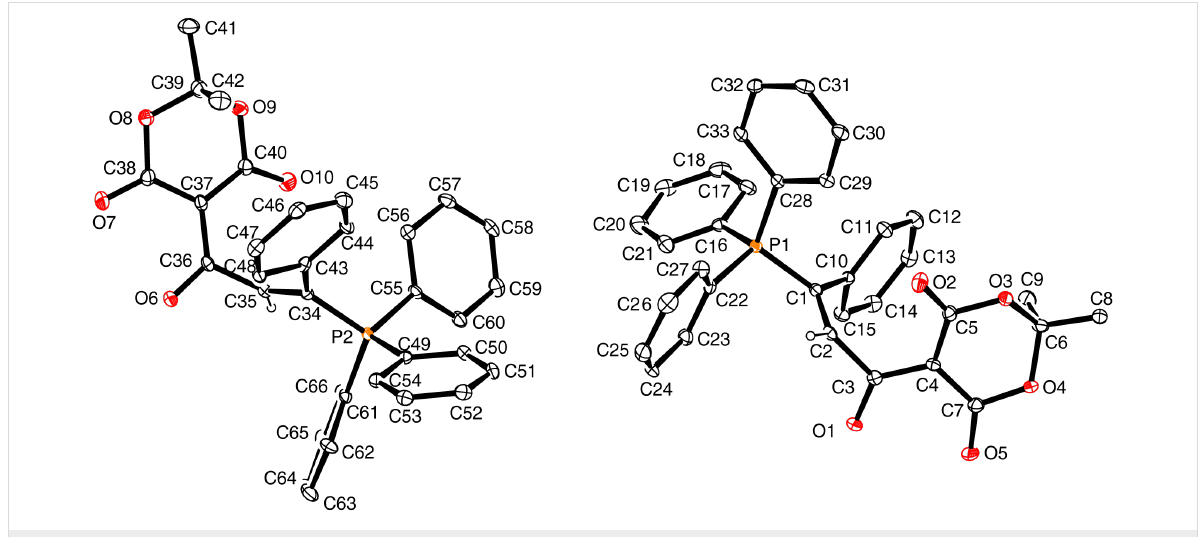
Figure 2: Solid-state structure of E - 3a (ORTEP plot), two symmetry-independent molecules in the triclinic unit cell.